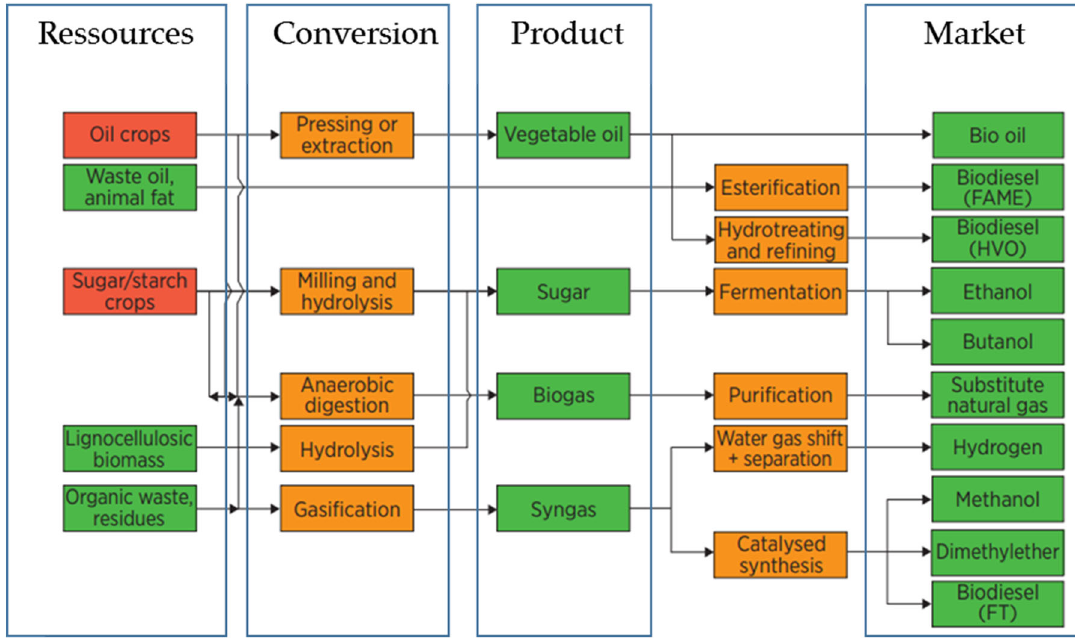
Figure 6. Synopsis of traditional and advanced biofuels production pathways [11].